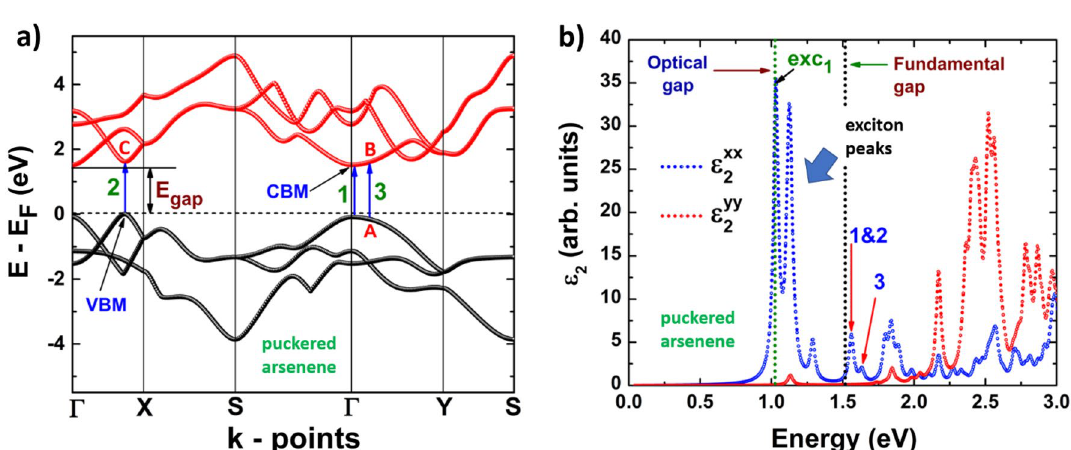
Figure 11. ( a ) Electronic band structure of puckered arsenene including the information of two important direct transitions. ( b ) Dielectric function imaginary part of puckered arsenene showing the values of the corresponding optical and fundamental gaps as well as exciton peaks. The peaks associated with direct transitions depicted in ( a ) are also located at the same energies, but the intensities are different. From Fig. 8b, we can see that the optical gap in blue phosphorene is equal to 2.12 eV, which is the energy at which the first peak is observed, and it is equal to the energy of the first exciton level (ground state). This peak is the same for xx and yy components. We can also observe the presence of ten other exciton levels: five are due to polarization along the x -axis, and the other five are due to polarization along the y -axis. In Fig. 8b, information about two important direct electronic transitions is also provided. They are labeled as 1 and 2 in Fig. 8a: 1 is the direct transition from a local maximum in the valence band located in an intermediate point between Γ and M (labeled as A), and direct transition 2 is from the point labeled as B to the conduction band minimum. The optical response of black phosphorene is depicted in Fig. 9b. We can clearly see an anisotropic behavior of the optical response. If the incident excitation is along the y -axis, the response is generated for energies around 2.85 eV, as the first peak for this polarization is observed near that energy. However, if the polarization is along the x -axis, the optical response is seen for lower energies, the first peak is observed at 1.29 eV, which is equal to the optical gap and it correspond to the first exciton level. The contribution to this peak comes from the polariza- tion along the x -axis, as well as from the two following excitonic peaks. In this way, the excitonic peaks are only coming from polarization along x -axis, with no contribution from polarization along y -axis. As the electronic behavior of the system is direct, the peak located at 1.83 eV is attributed to the direct electronic transition (labeled between Γ and Y (labeled as B). Therefore, a direct transition to this point is possible, from a point labeled as A